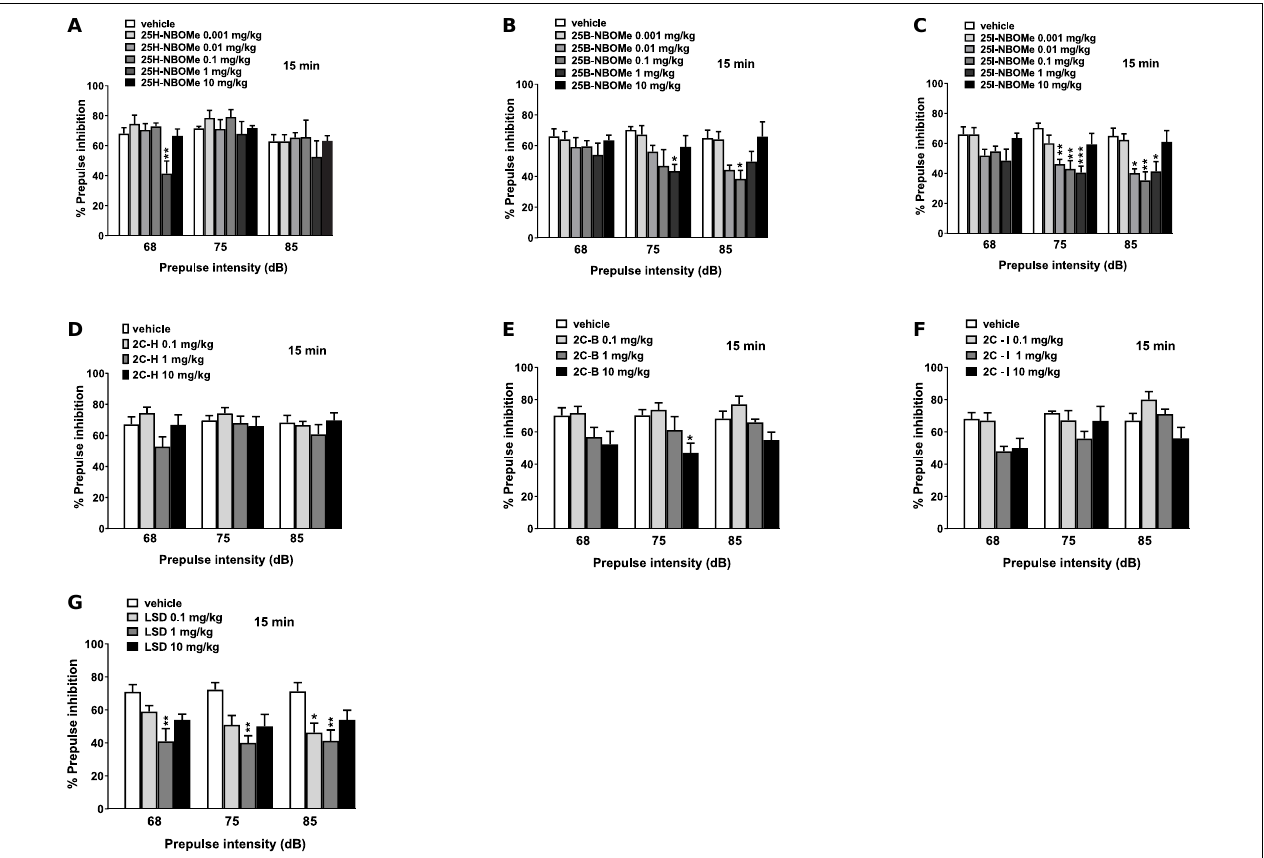
FIGURE 11 | Effect of 25H-NBOMe (0.001–10 mg/kg i.p.) (A) , 25B-NBOMe (0.001–10 mg/kg i.p.) (B) , 25I-NBOMe (0.001–10 mg/kg i.p.) (C) , 2C-H (0.1–10 mg/kg i.p.) (D) , 2C-I (0.1–10 mg/kg i.p.) (E) , 2C-B (0.1–10 mg/kg i.p.) (F) , and LSD (0.1–10 mg/kg i.p.) (G) on prepulse inhibition (PPI) in mice. Effects on PPI are shown for the three prepulse intensities (68, 75, and 85 dB) at 15 min after treatment. PPI was expressed as the percentage decrease in the amplitude of the startle reactivity caused by presentation of the prepulse (% PPI; see section “Material and Methods”) and values represent mean ± SEM of 10 animals for each treatment. The statistical analysis was performed with a one-way ANOVA followed by Bonferroni’s test for multiple comparisons. * p < 0.05, ** p < 0.01 and *** p < 0.001 vs.